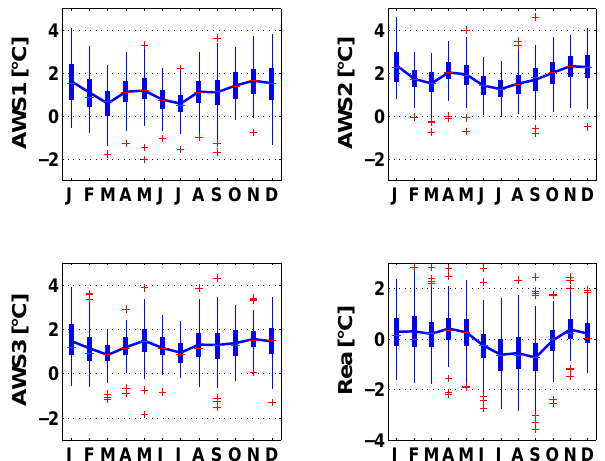
Figure 2. Monthly statistics of daily air temperature time se- ries at AWS1 (5050ma . s . l . ), AWS2 (4820ma . s . l . ), and AWS3 (4950ma . s . l . ), and of the a priori selected predictor rea-ens-air (as defined in the text). Shown are the means (blue solid line) and the medians (red dashes). The edges of the thick blue bars are the 25 and the 75 percentiles. The thin blue bars extend to the most ex- treme data not considered as outliers, and the red crosses are the outliers. All statistics are computed for period 1 (July 2006 to De- cember